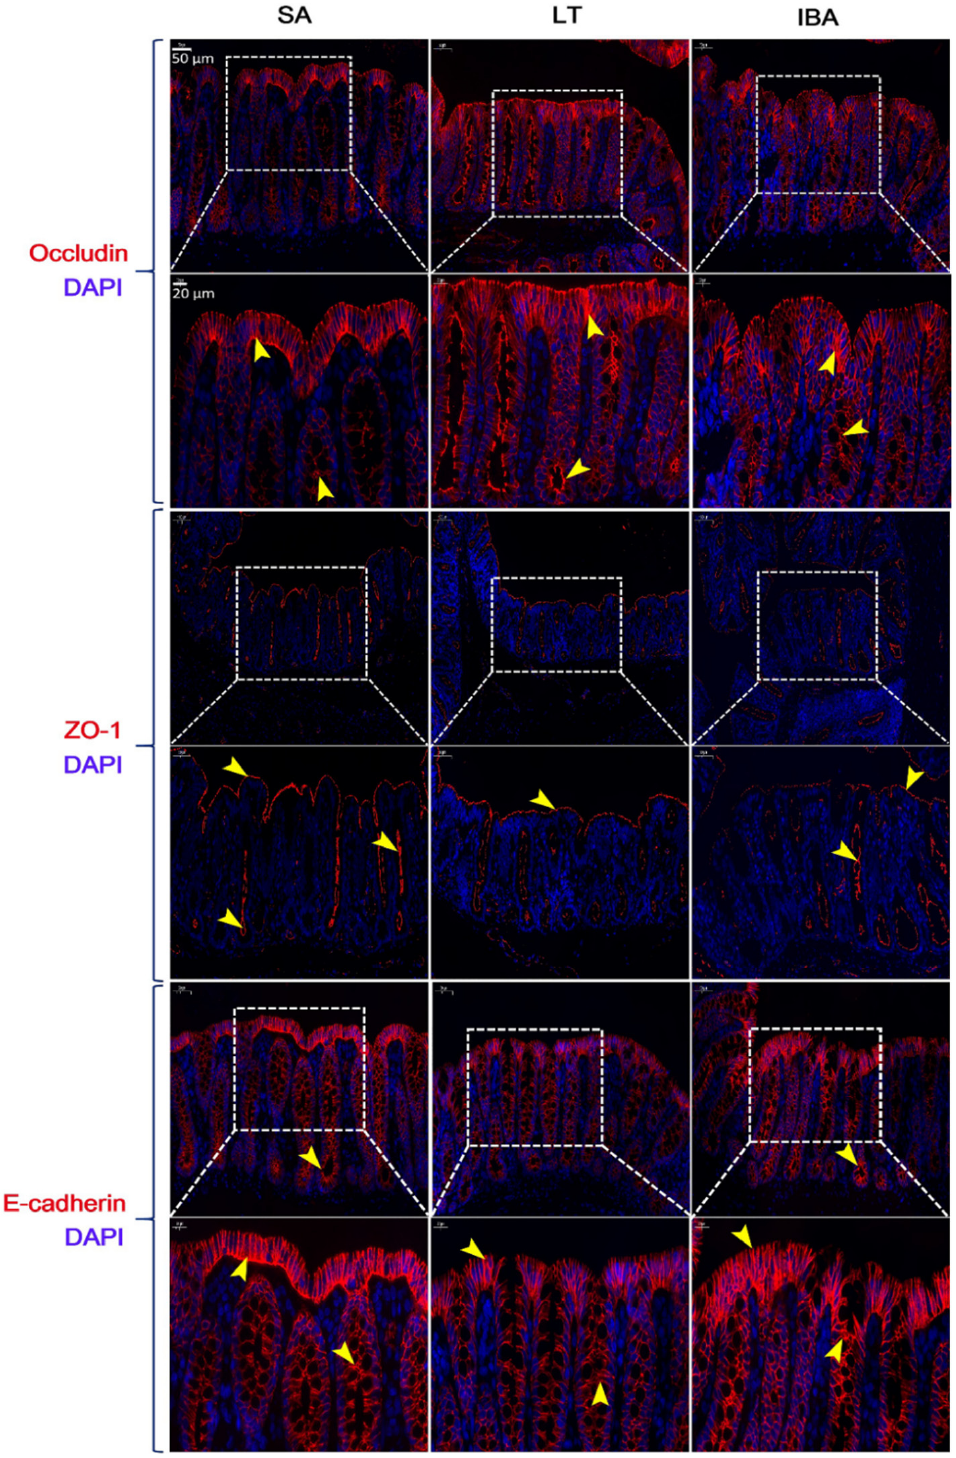
Figure 7. Distribution of occludin, E-cadherin, and ZO-1 proteins in colonic mucosa of Daurian ground squirrels. DAPI (blue) marks the nucleus, CY3 (red) marks occludin, E-cadherin, and ZO-1. Positive expression (yellow arrows). n = 3. SA, summer active; LT, late torpor; IBA, interbout arousal.